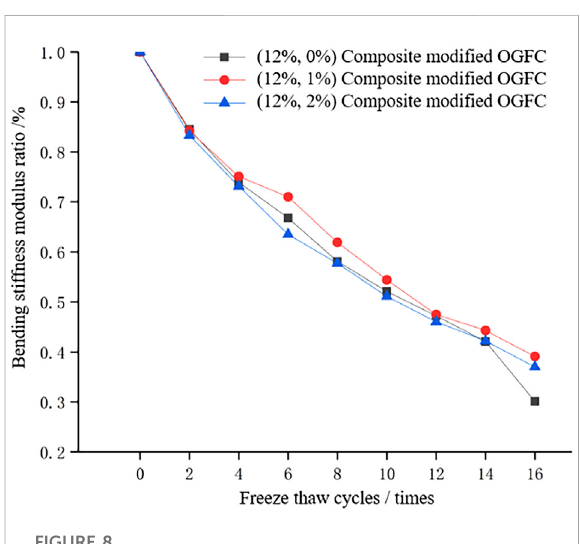
FIGURE 8 Variation diagram of trabecula stiffness modulus ratio of different blending ratio specimens.